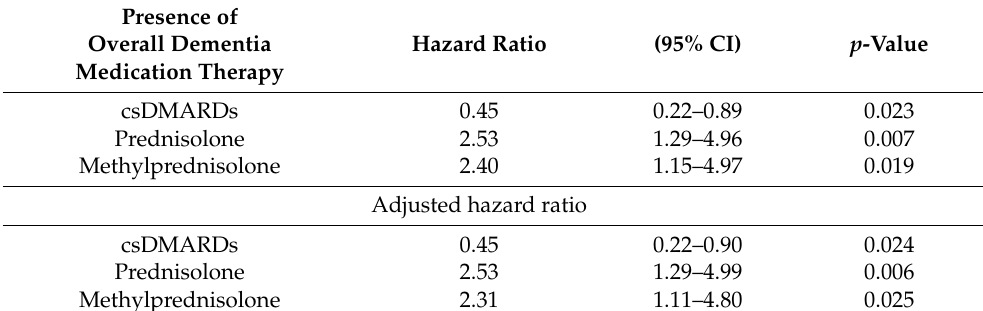
Table 4. Hazard ratios (HRs) and 95% confidence intervals (CIs) for dementia in patients with axSpA during 7-year follow-up ( n =